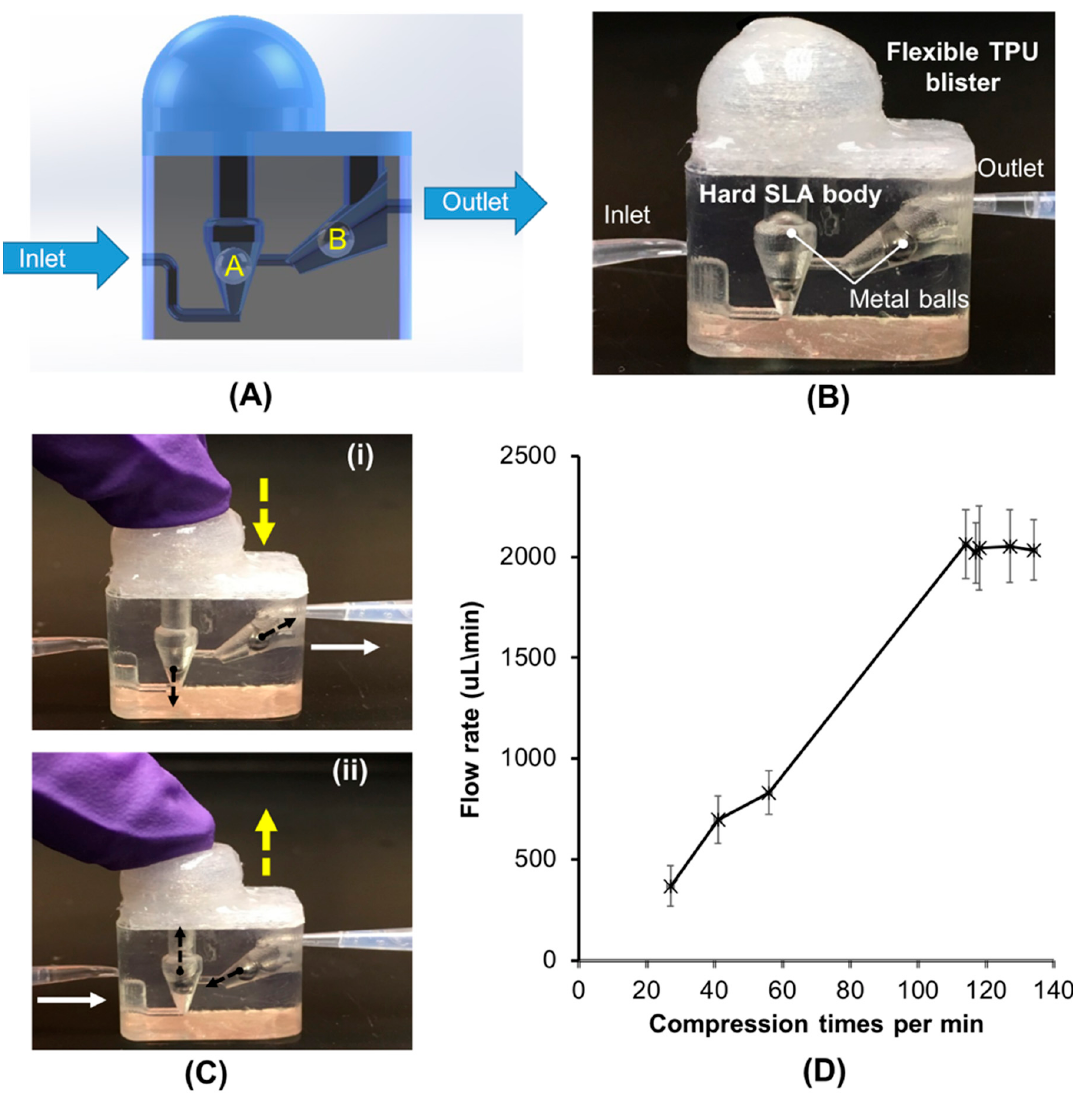
Figure 3. Finger-powered, hard–soft hybrid micropump. ( A ) Schematic illustration of the work principle of the hybrid micropump. ( B ) A photograph of the hard–soft hybrid pump. ( C ) A sequence of images illustrating the finger-powered pumping process in the hybrid micropump. The water containing food dye was used in this test. ( D ) The flow rate ( μ L/min), as a function of function of the compression times (expressed in terms of times per min). n = 3.